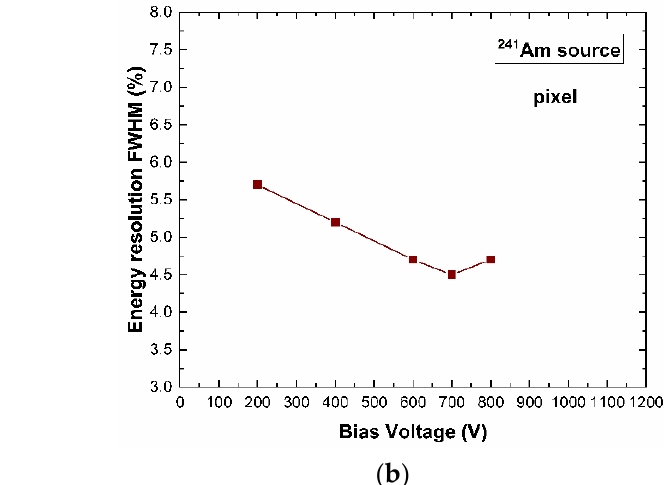
Figure 4. ( a ) 241 Am energy spectra of a tested pixel at different bias voltages; the low-energy background, due to the charge sharing effects, is reduced by increasing the voltage. ( b ) The energy resolution FWHM at 59.5 keV vs. the bias voltage: the best energy resolution is obtained at − 700 V. Figure 5 shows the energy spectra under different radiation sources: the energy lines of 22.1 and 24.9 keV of the 109 Cd source, the 59.5 keV line of 241 Am source and 122.1 and 136.5 keV of the 57 Co source. The background at low energies was due to the charge shar- ing, while the energy peaks at 23.2 and 27.5 keV represent the fluorescent X rays (Cd-Kα and Te- Kα X-rays) from the adjacent pixels and internal-guard-ring.